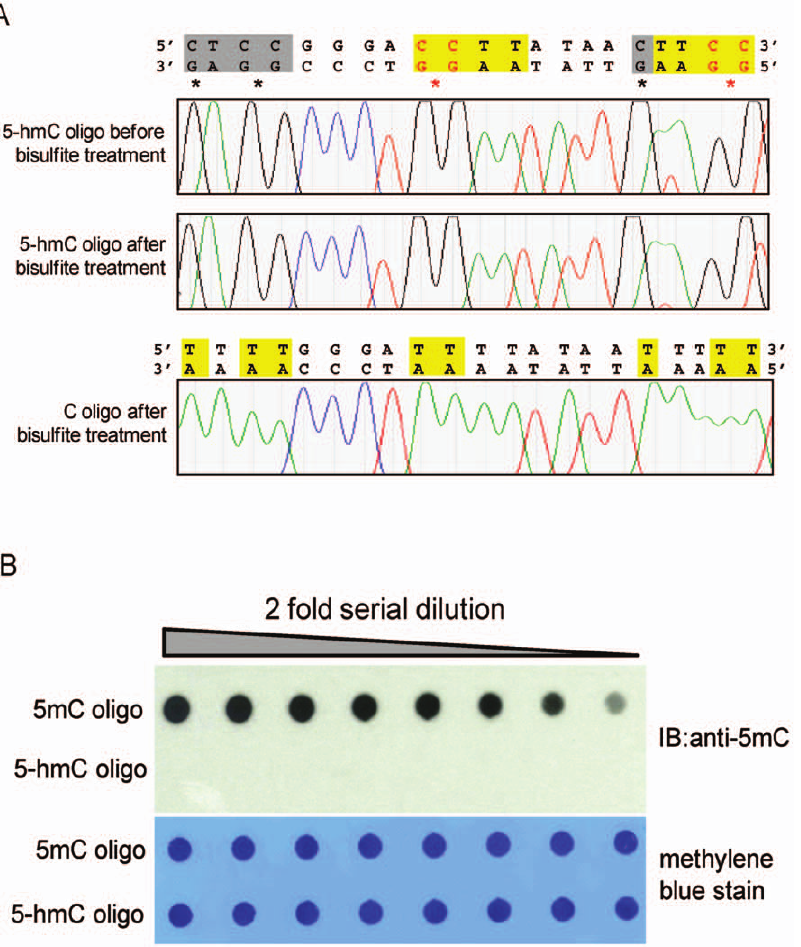
Figure 4. 5-hmC did not undergo C- . T transitions after bisulfite treatment and 5-mC antibody cannot recognize 5-hmC in DNA. (A) Shown are sequencing traces of 5-hmC-containing oligonucleotide ( Figure 2A ) before and after bisulfite treatment ( top and middle panels ). The control C-containing oligonucleotide shows complete conversion of all C’s in the top strand (highlighted sequences) to T’s ( lower panel ). (B) Dot-blot assay of monoclonal anti-5-mC antibody detection of oligonucleotide ( Figure 2A ) containing 5-mC or 5-hmC ( Figure 2A ). Recognition on DNA by the anti-5-mC antibody is shown in the top panel, loading control is shown by the methylene blue stain in the bottom panel. The anti-5-mC antibody only recognizes the 5-mC oligonucleotide but not the 5-hmC oligonucleotide.